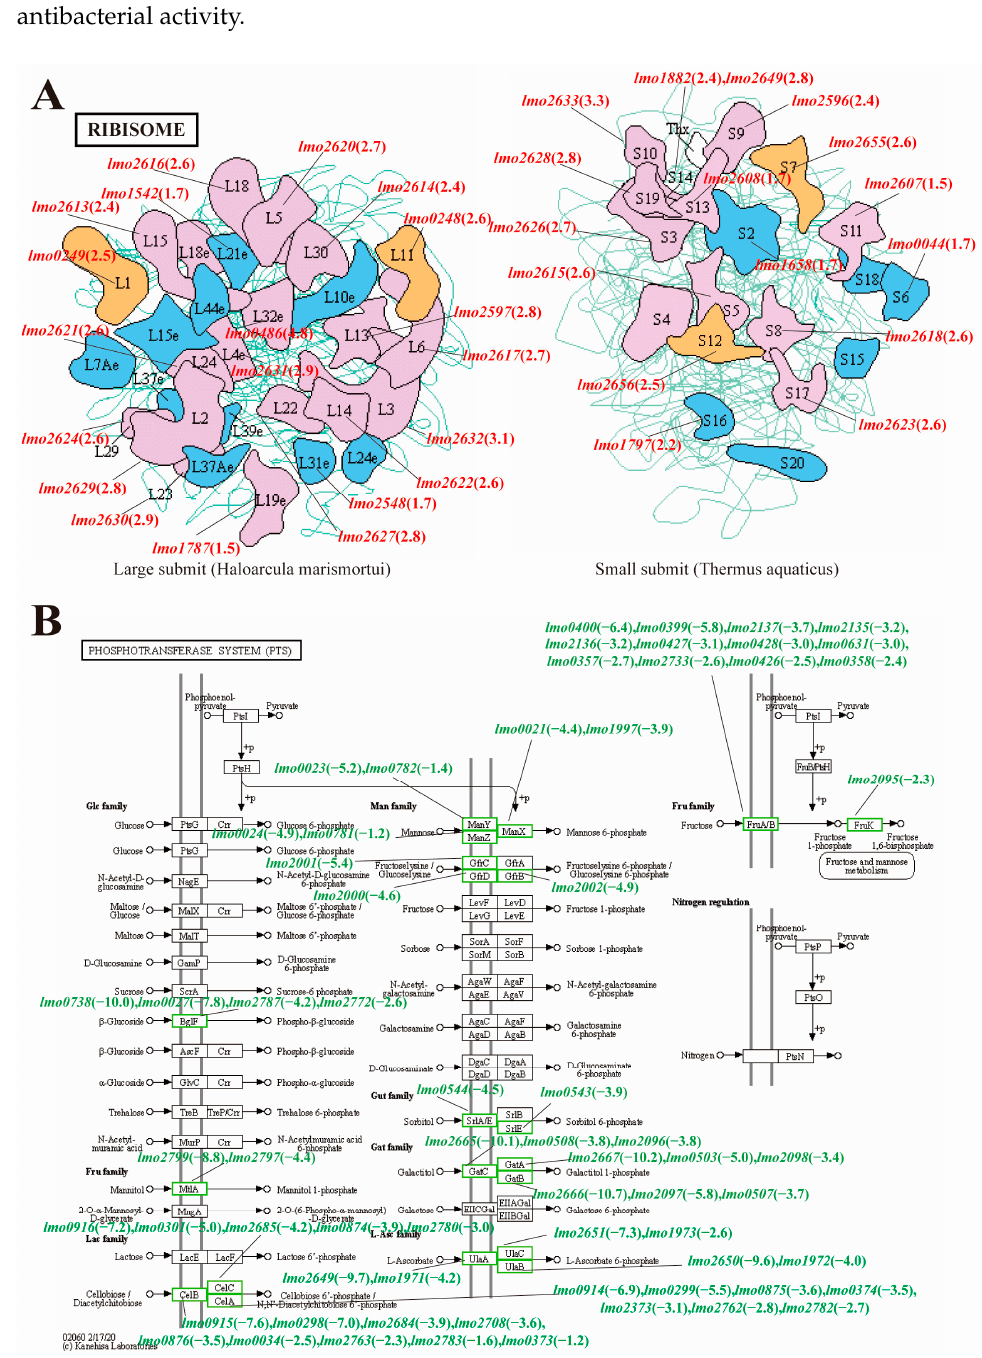
Figure 4. KEGG pathway analysis of ribosomes ( A ) and PTS ( B ). The red fonts in the figure represent significantly up-regulated genes in related pathways, and the green fonts represent significantly down-regulated genes in related pathways.